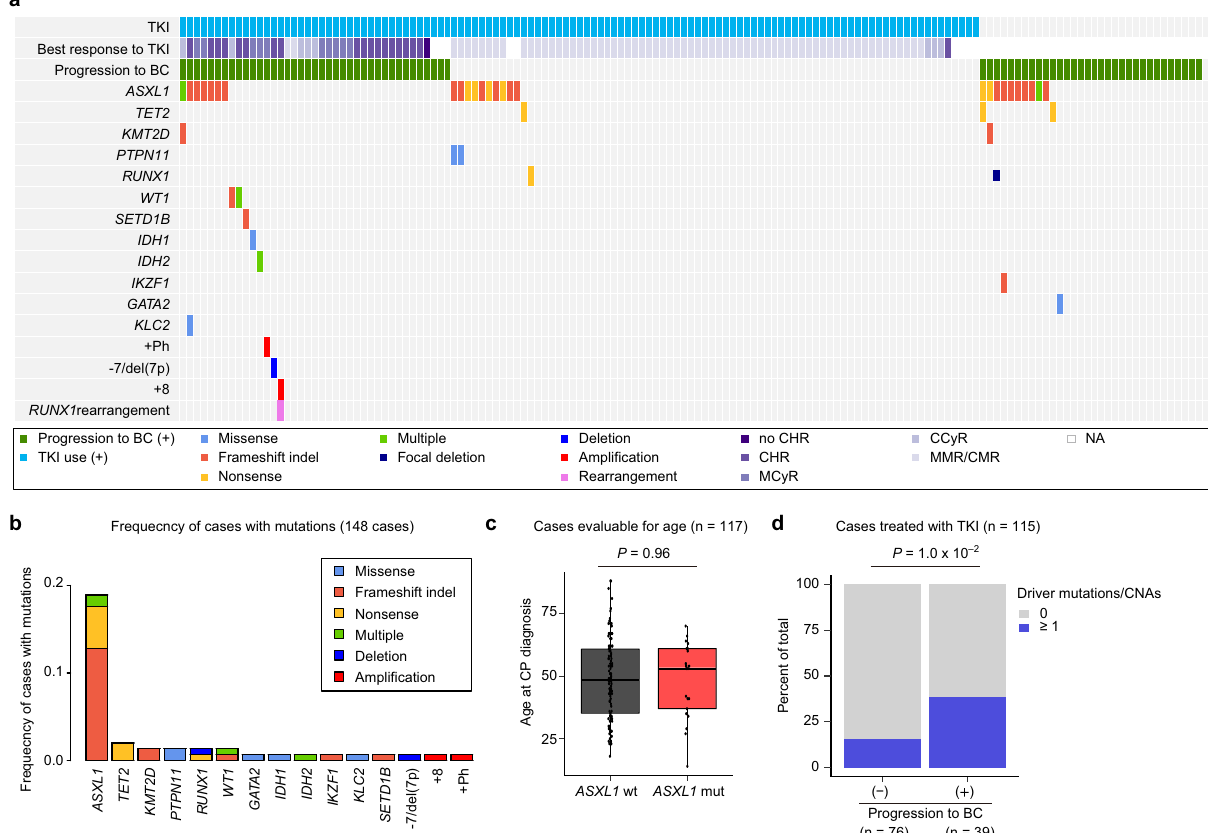
Fig. 6 Genetic landscape of CML-CP. a Summary of genetic lesions in 148 CP patients. Each column indicates one patient. Clinical annotations including TKI usage for CP treatment, best response to TKI, and progression to BC are also shown. NA not available. b Frequencies of mutations in 148 CP patients. Recurrently mutated or known driver genes are described. Categories of mutations are depicted in different colours, and “ multiple ” indicates ≥ 2 distinct mutations found in the same gene in the same patient. c Box plot showing age at CP diagnosis according to the presence of ASXL1 mutations. The median, fi rst, and third quartiles are indicated and whiskers extend to the furthest value within 1.5× the interquartile range. The two-sided Wilcoxon rank-sum test was used to calculate the P value. wt wild type, mut mutated. d Proportion of cases harbouring any genetic abnormalities according to progression to BC. P values were evaluated using the Fisher ’ s exact